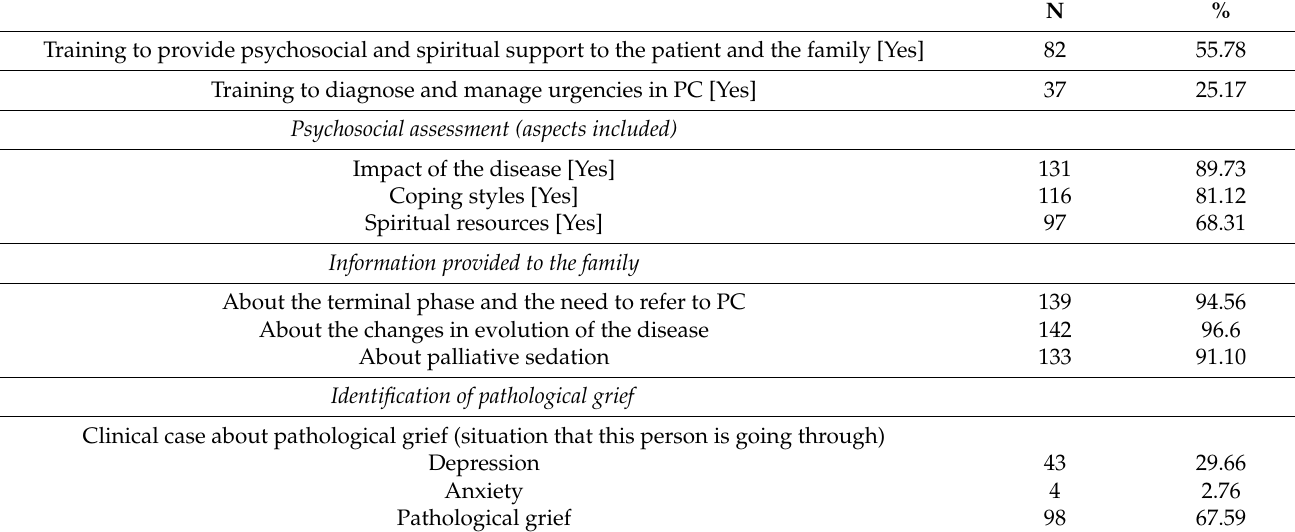
Table 5. Management of the psychosocial sphere by